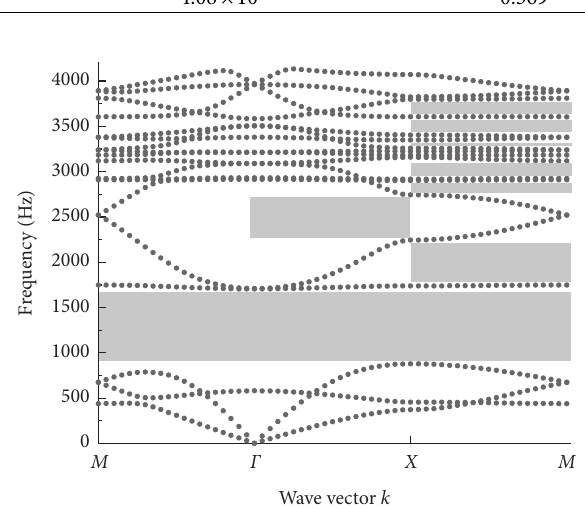
Figure 2: Band structure for xy -mode of damped rail with two- dimensional honeycomb PCs.